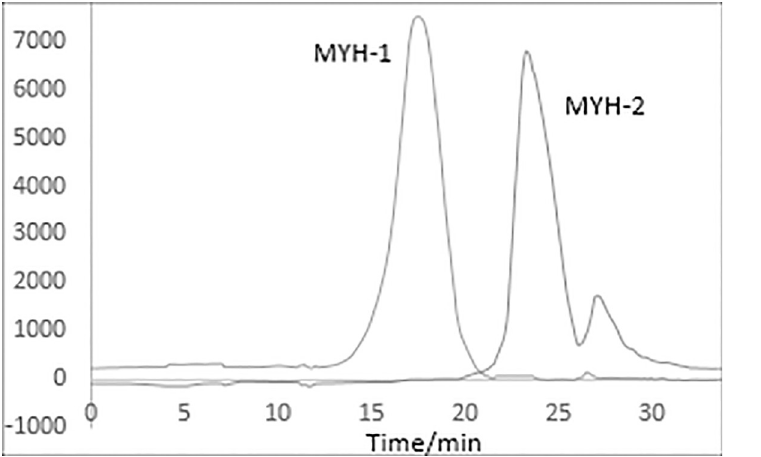
Fig 6. HPGPC chromatograms of MYH-1 and MYH-2.